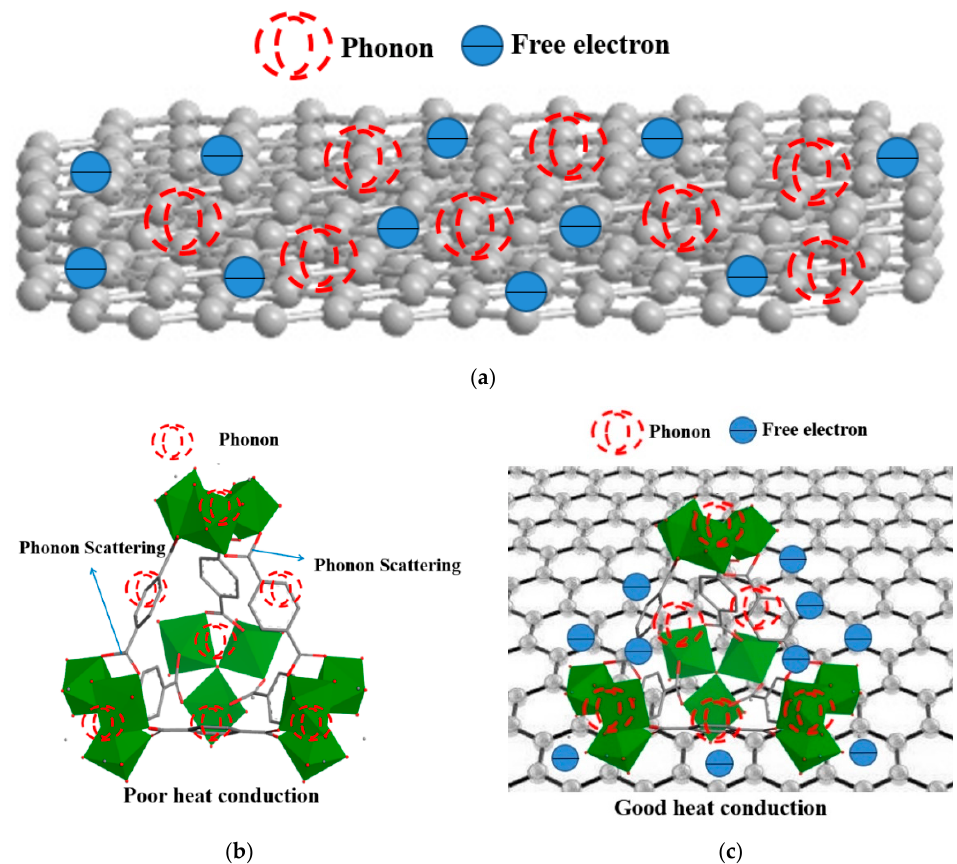
Figure 7. Schematic diagram of structure and heat conduction mechanism for ( a ) FLG, ( b ) MIL-101 and ( c ) MIL-101/FLG composite.